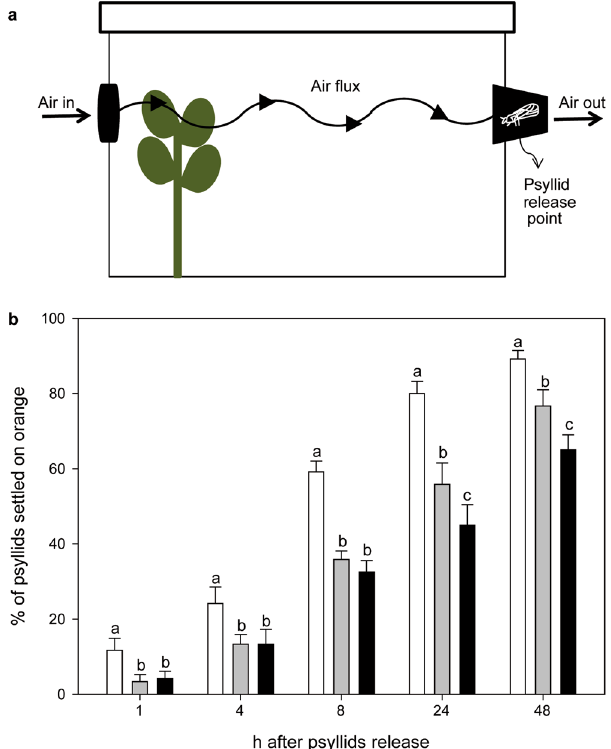
Figure 4. ( a ) Graphic representation of the device developed to evaluate in no-choice tests the effect of plant volatiles on D . citri . ( b ) Percentage of D . citri psyllids settled 1, 4, 8, 24 and 48 h after their release on sweet orange flushes when presented alone (white bars), caged with Arabidopsis At5g23960 KO line (grey bars) or caged with Arabidopsis At5g23960 OE line (black bars). For a given time, the bars with different letters indicate significant differences between the treatments tested ( * P < 0.1). Error bars represent SE (n = 12 independent tests, 10 responsive psyllids evaluated in each